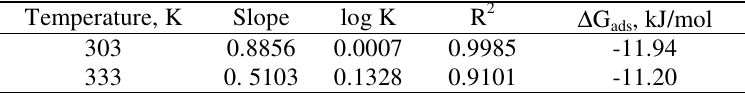
Table 5. Langmuir adsorption